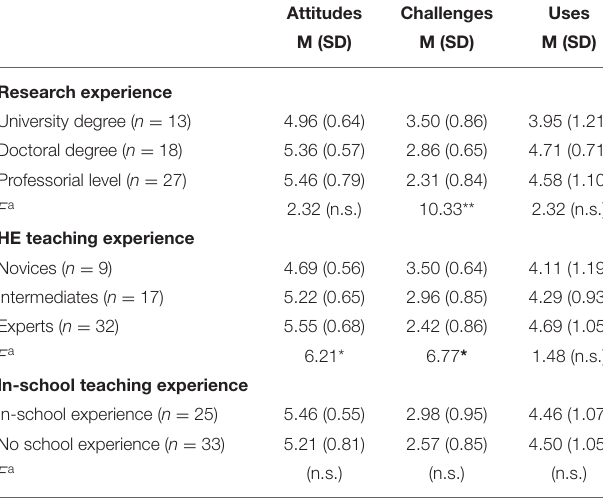
TABLE 7 | Differences in the mean scores of the teacher educators on attitudes, challenges, and uses, and F -value. Attitudes